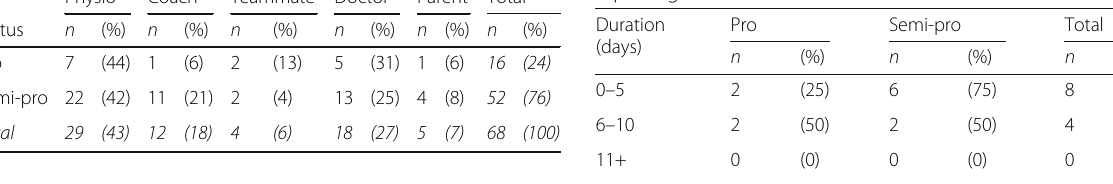
Table 4 Days benched or omitted from training/playing after